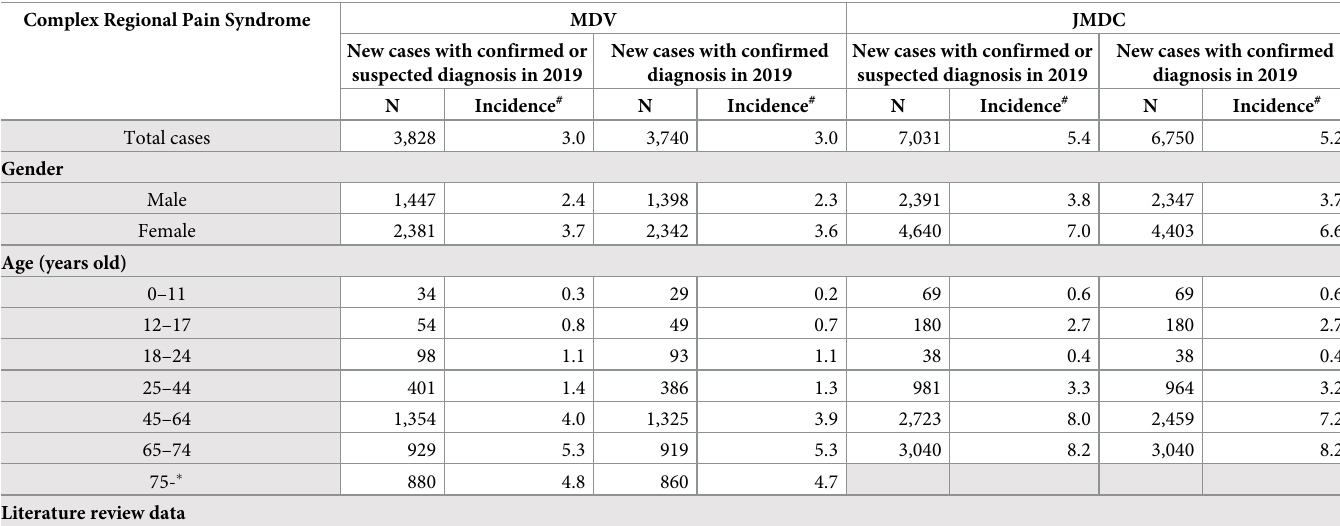
Table 8. Estimated incidence of complex regional pain